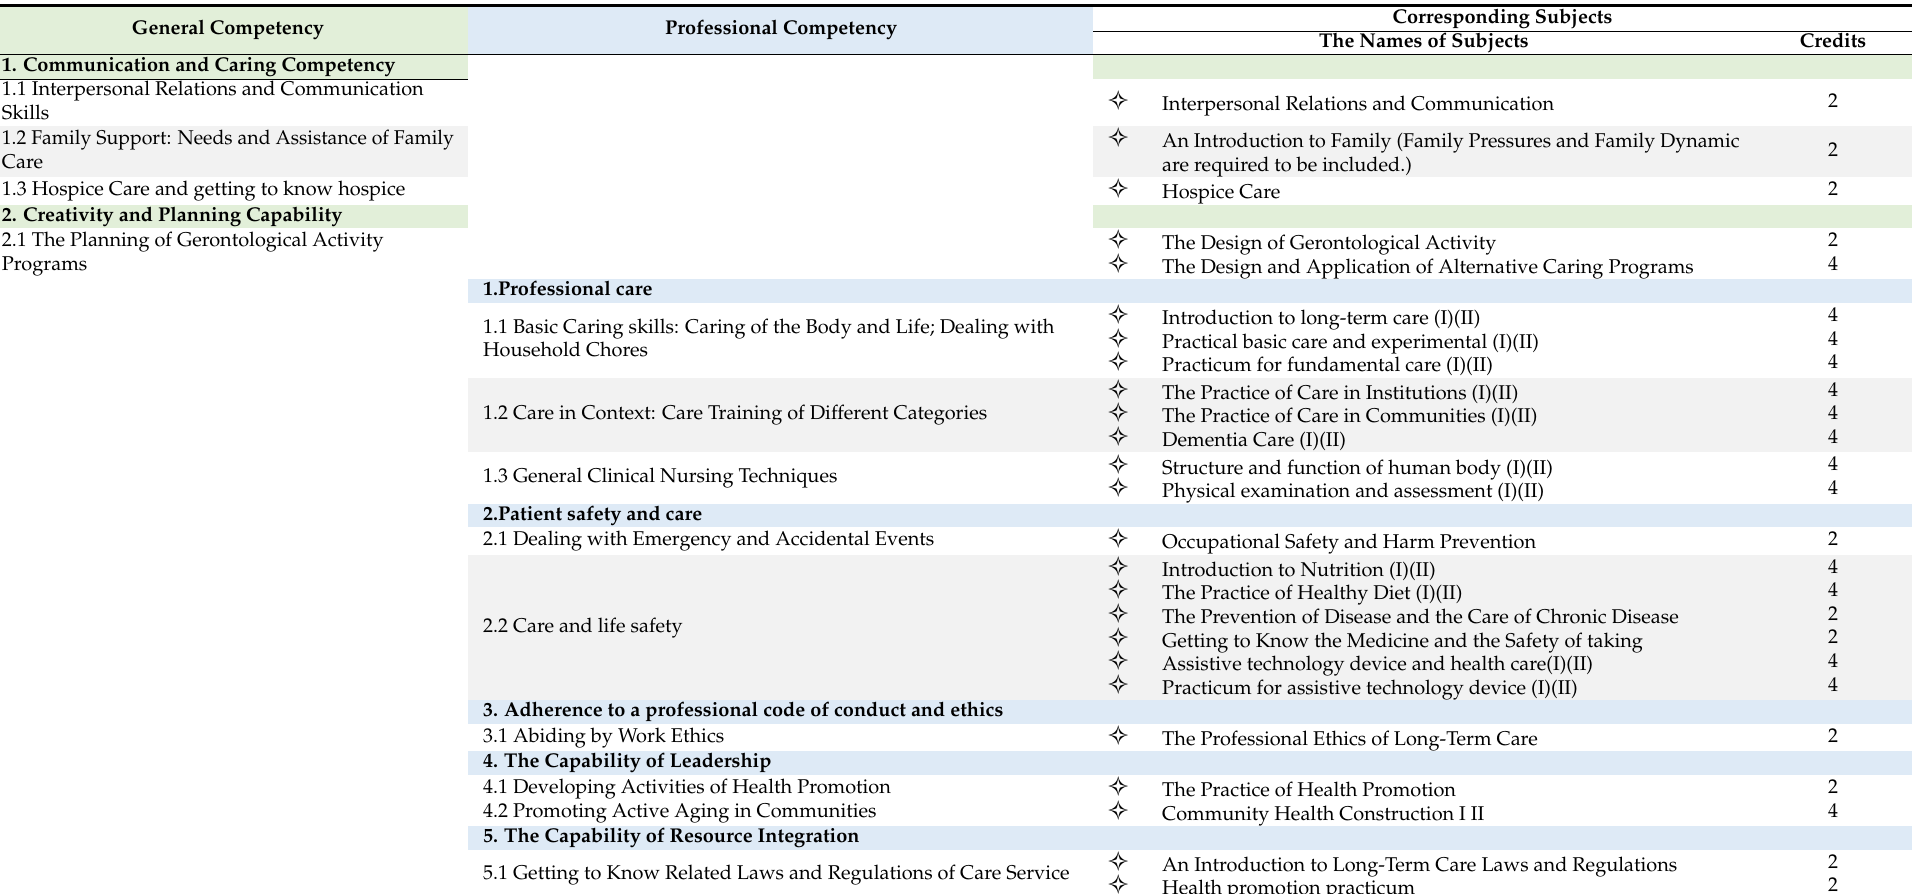
Corresponding Subjects The Names of Subjects Credits